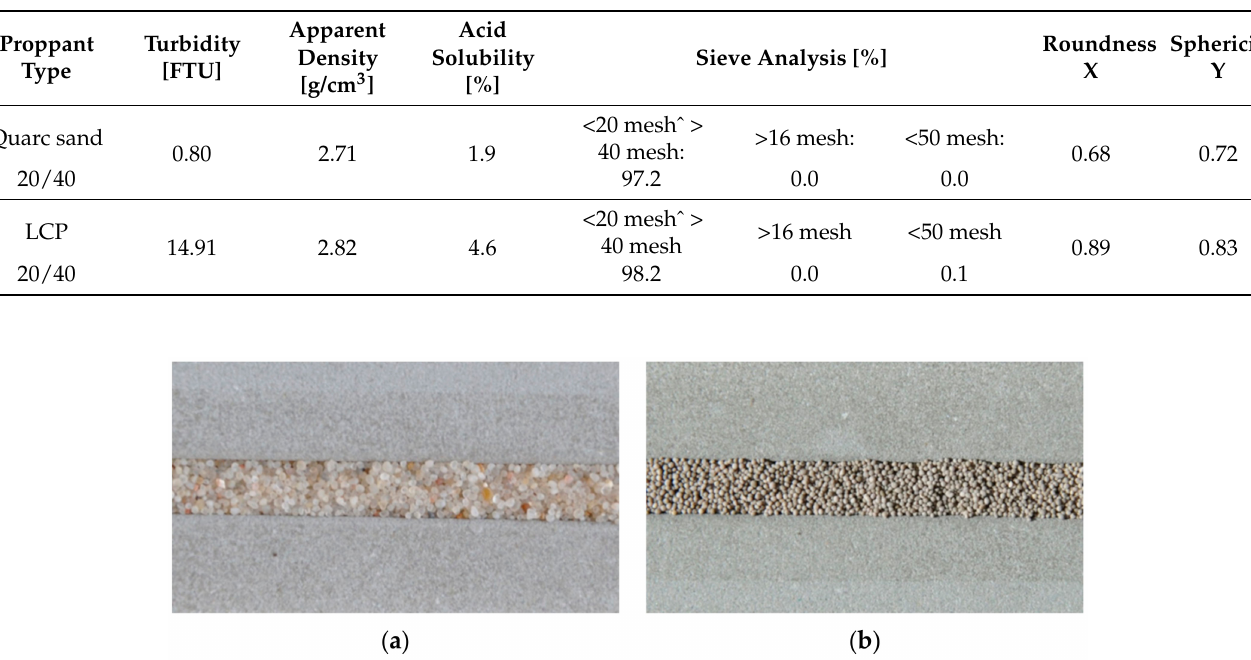
Figure 2. The photo of the fracture filled with quartz sand 20–40 mesh ( a ), and light ceramic proppant 20–40 mesh ( b ), with a surface concentration of 9.76 kg/m 2 , between two Ohio sandstone rock blocks, before compressing it on the hydraulic press.